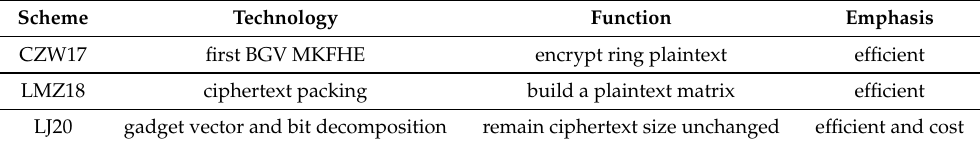
Table 3. Summary of Section